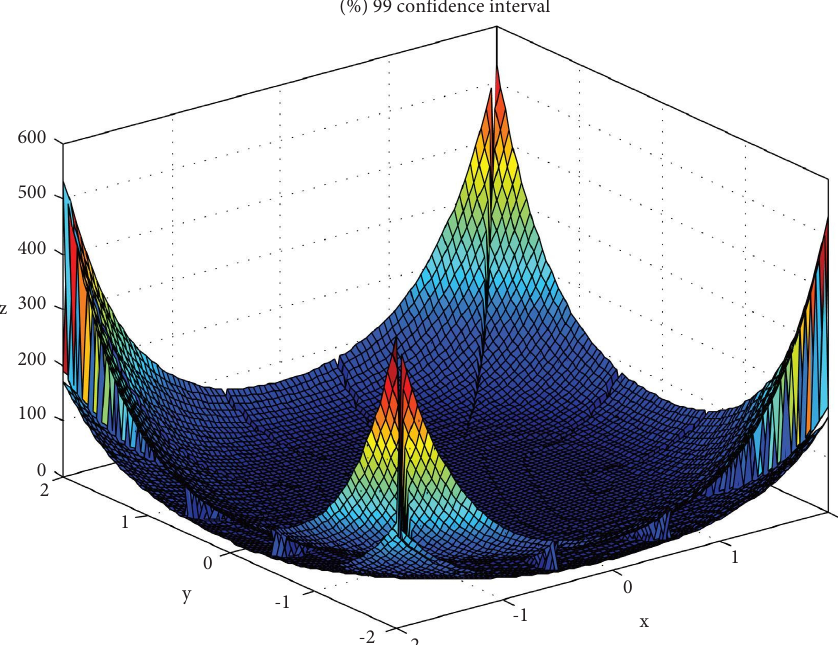
Figure 9: Te 99% confdence interval of equation (38) for α � 1 , β �